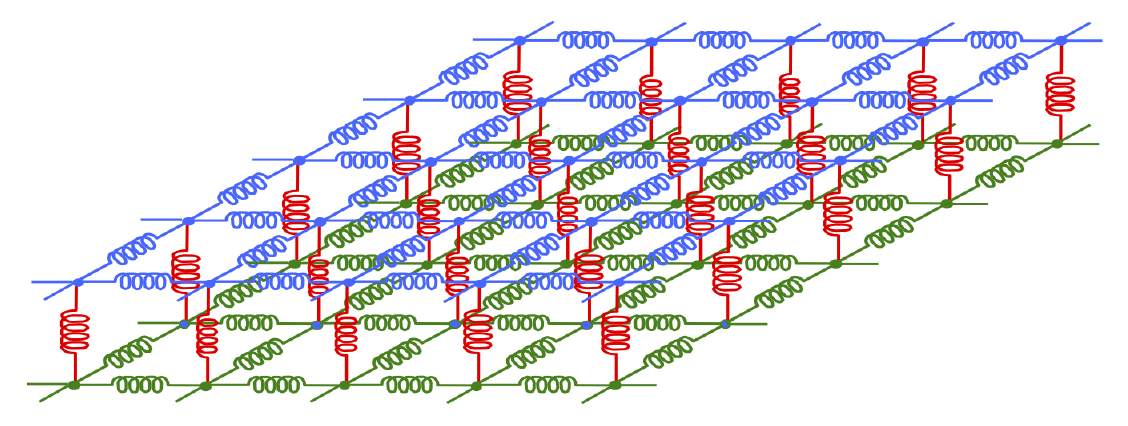
Fig. 1. A schematic illustration of the mechanical bidomain model. The green springs represent the intracellular cytoskeleton, the blue the extracellular matrix, and the red the integrins. The figure illustrates a two-dimensional version of the model, but this article analyzes a three-dimensional